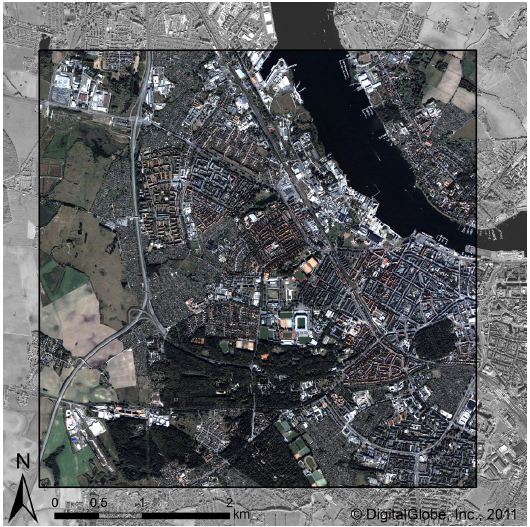
Figure 1: Quickbird satellite image subset of Rostock ( c (cid:13) DigitalGlobe, Inc.,